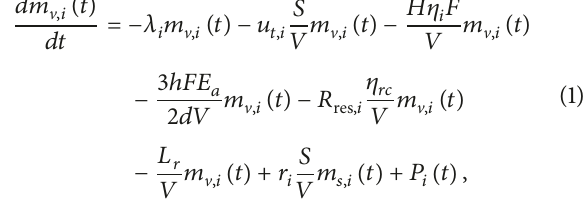
𝑡 = 100 s, 500 s, 1000 s, 1500s Immediate